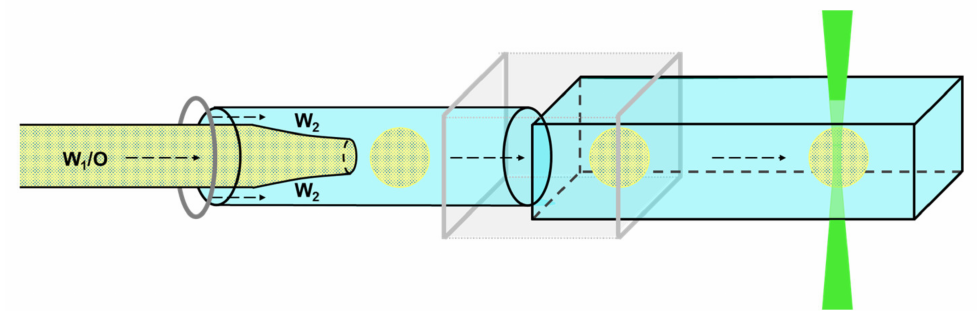
Figure 5. Scheme of the capillary system including the measuring point.